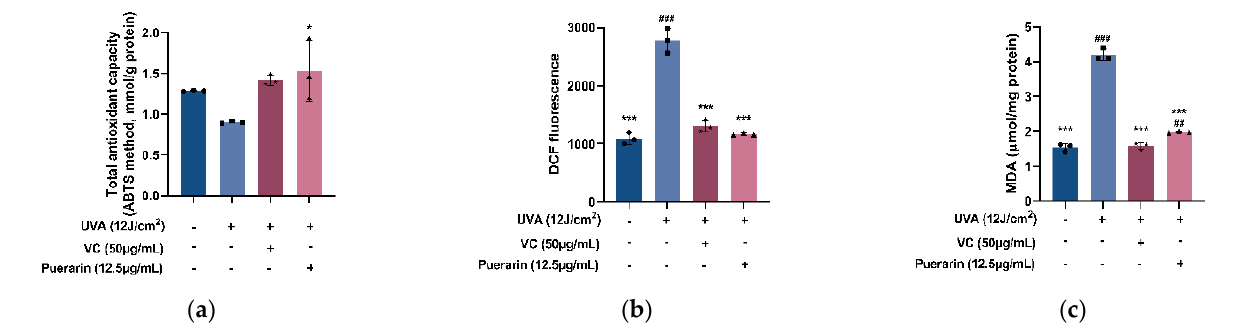
Figure 2. Effects of puerarin on cellular antioxidant indexes: ( a ) Effects of puerarin on total antioxidant capacity of HSF with UVA-induced oxidative damage. ( b ) Effects of puerarin on reactive oxygen species (ROS) production induced by UVA stimulation. ( c ) Effects of puerarin on lipid oxidation product malondialdehyde (MDA) content in HSF with UVA-induced oxidative damage. ## p < 0.01, ### p < 0.001 as compared to the control group; * p < 0.05, *** p < 0.001 as compared to the